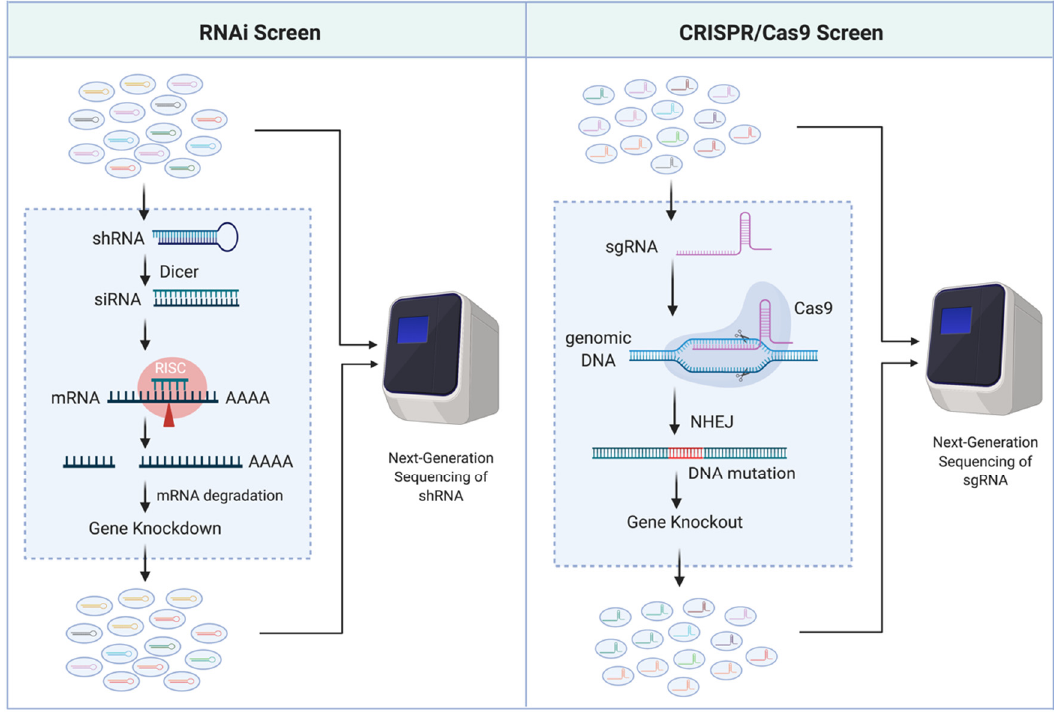
Figure 1. Scheme of RNAi and CRISPR / Cas9 high-throughput functional genetic screens.